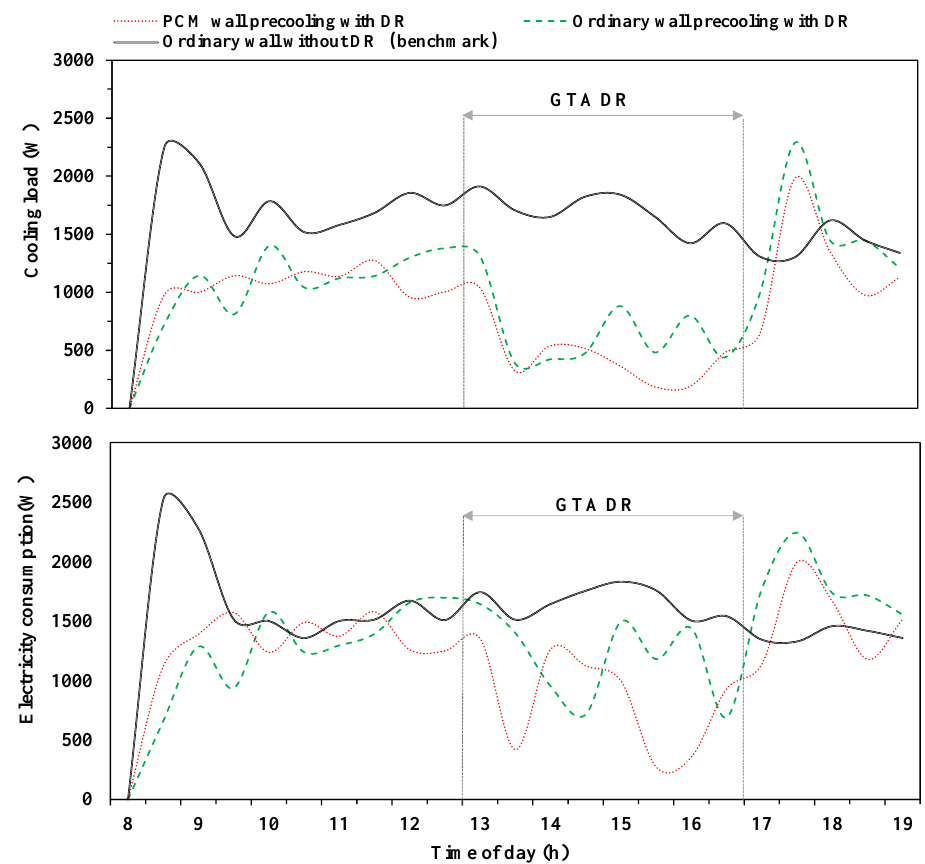
Figure 9. Cooling load and electricity consumption of experimental rooms.